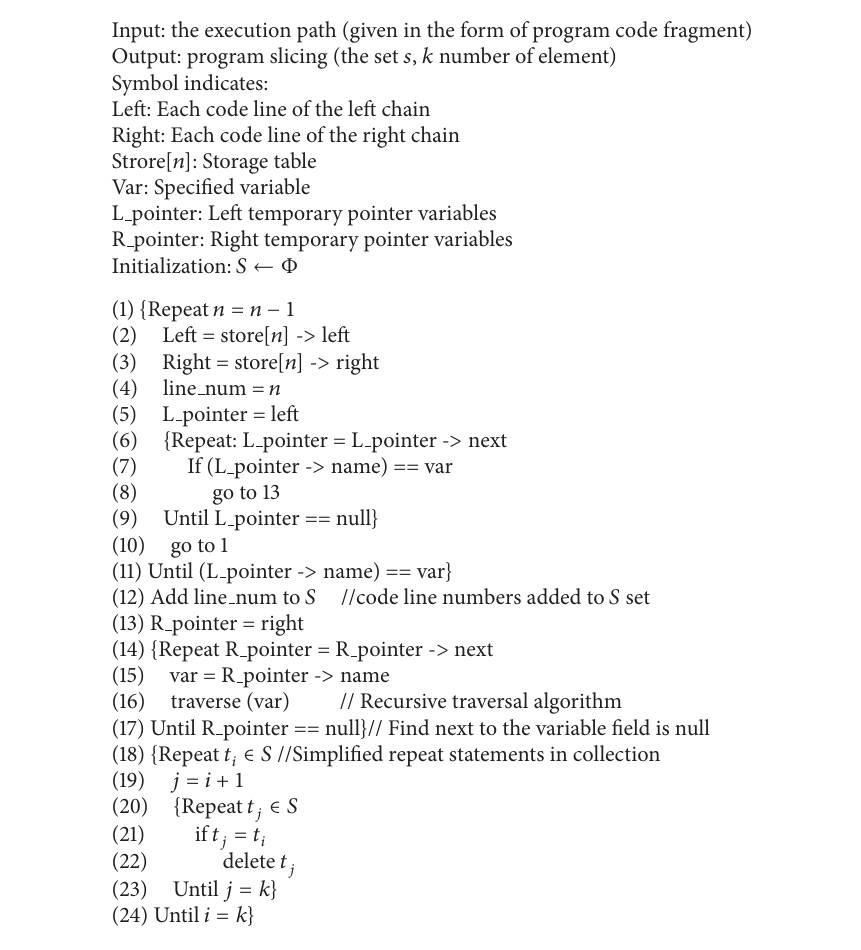
Algorithm 2: Traversal algorithm: traverse